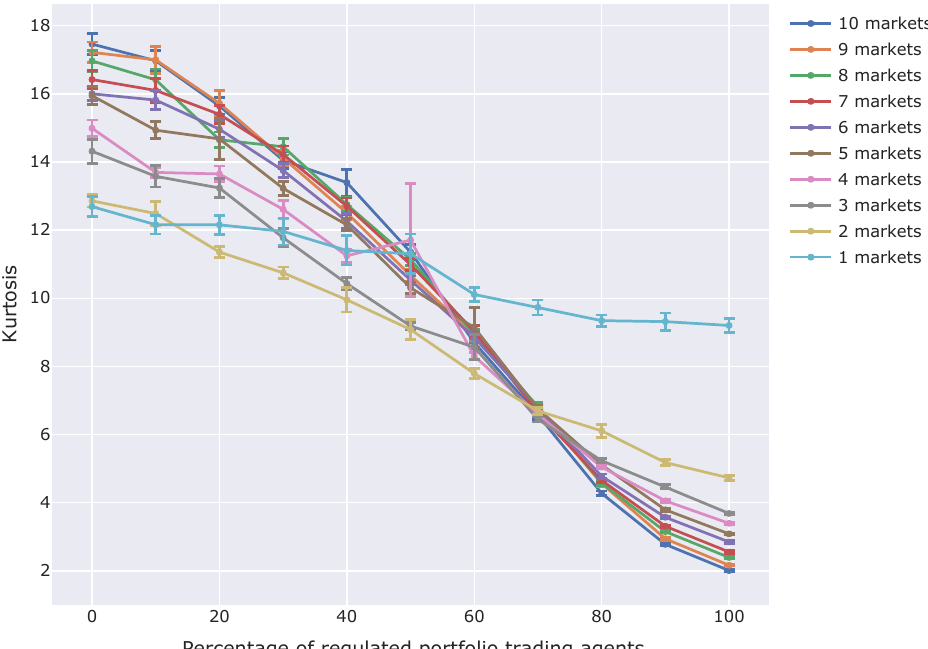
Figure 9. Kurtosis of price changes in the experiments for assessing the effect of CAR regulation. The horizontal axis is the percentage of regulated portfolio trading agents among all non-regulated and regulated portfolio trading agents. The vertical axis is kurtosis. Each series of plots shows results for a certain number of markets in the simulation. Error bars show standard deviations.